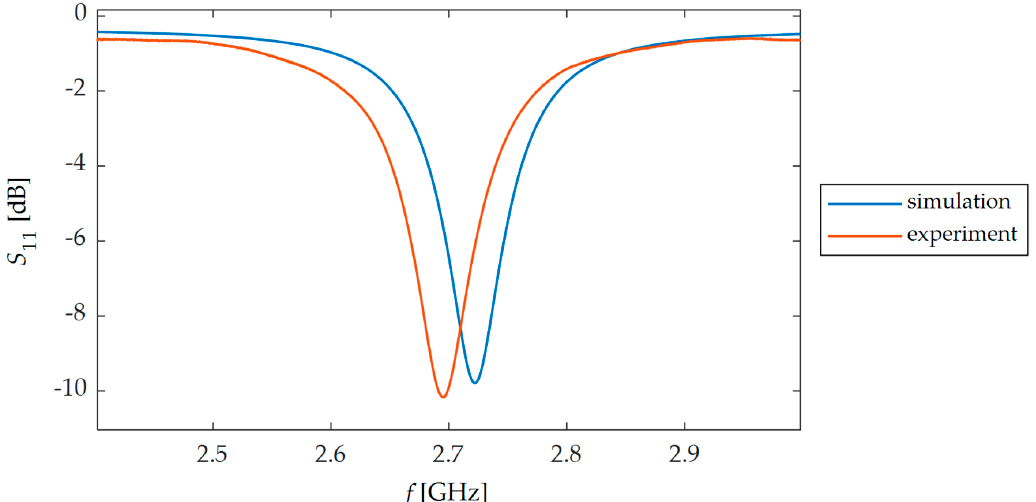
Figure 10. Calculated and measured reflection coefficient characteristics S 11 for second iteration of Sierpinski curve fractal.